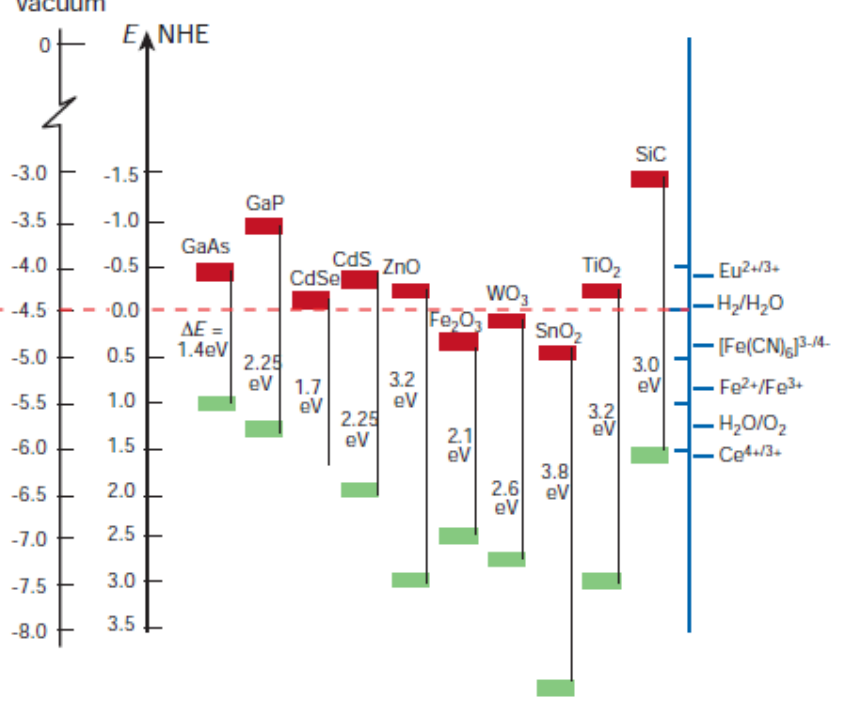
Figure 21. Valence and conduction band energies of various semiconductors, which have been used in solar cells. The outer left ordinate shows the energies referenced to the vacuum level, while the inner scale shows the normal hydrogen electrode scale (both in eV). (Reprinted by permission from Macmillan Publishers Ltd. [Nature (London)] [292], Copyright